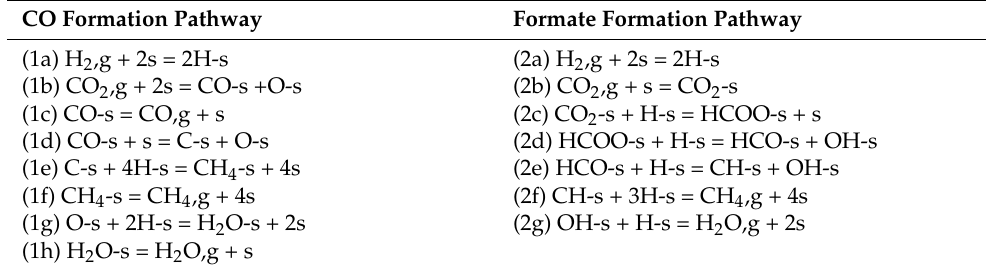
Table 2. Proposed elementary reaction steps for the reaction of CO 2 methanation, where “s” denotes an adsorption site onto the catalytic surface. Adapted from Ref. [228]. Copyright© 2021, Elsevier. CO Formation